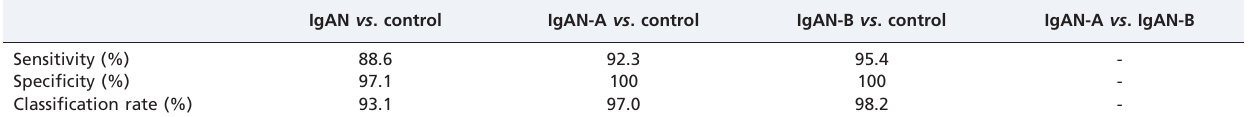
Table 3 - Sensitivity, specificity and classification rate calculated for the cross-validated OPLS-DA model applied to the spectra of serum samples from healthy controls and patients with IgAN.